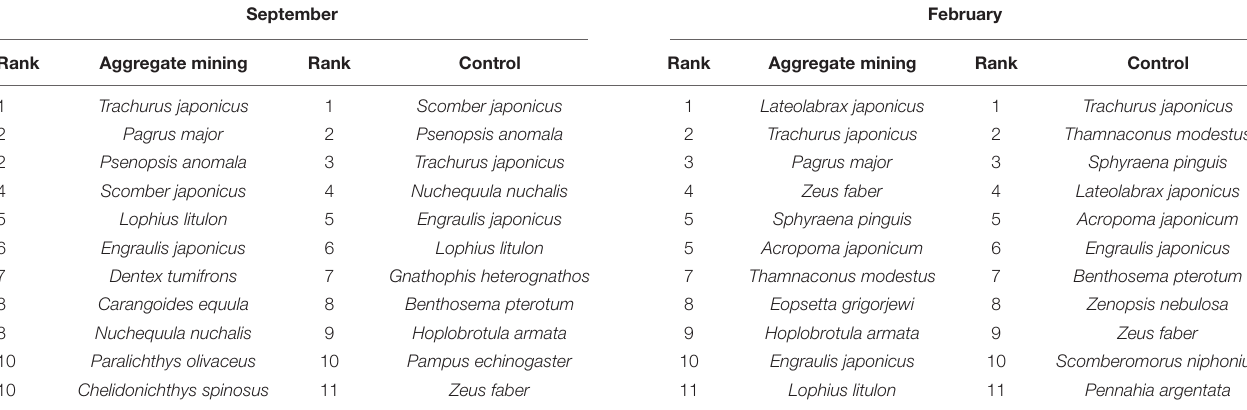
TABLE 4 | List of the most abundant fish species by sample collection areas in EEZ, the southern sea of